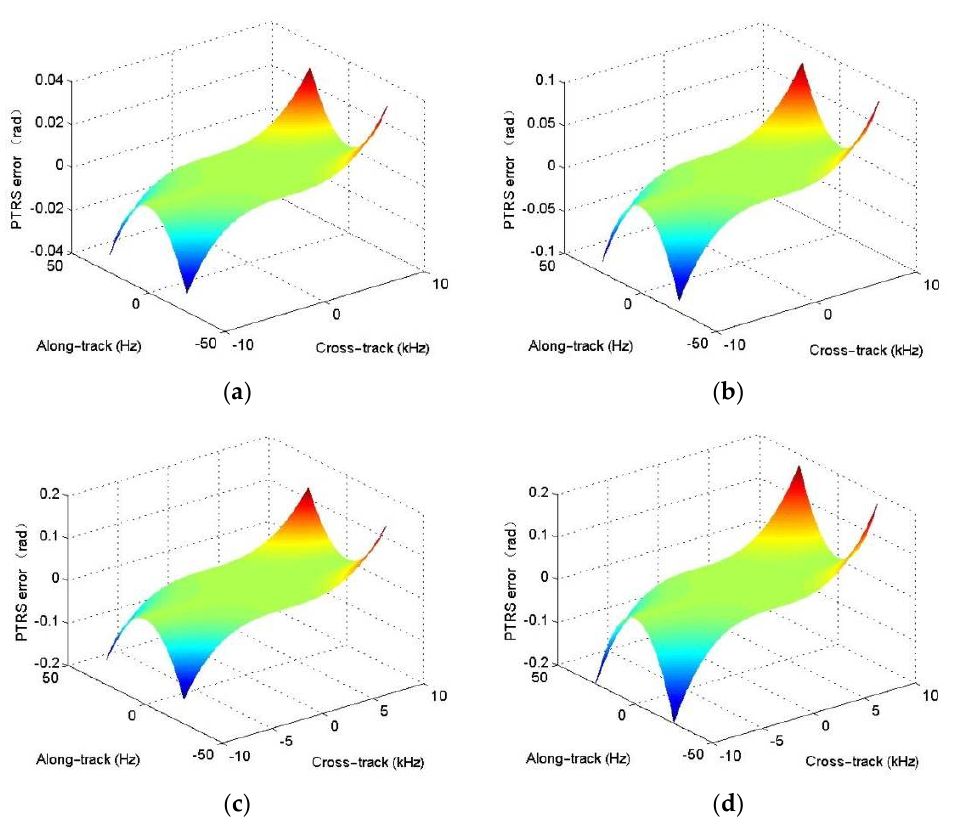
Figure 7. PTRS error for the last transmitter/receiver pair when the system works with a narrow- bandwidth. ( a ) r = 40 m; ( b ) r = 110 m; ( c ) r = 180 m; ( d ) r = 250 m.